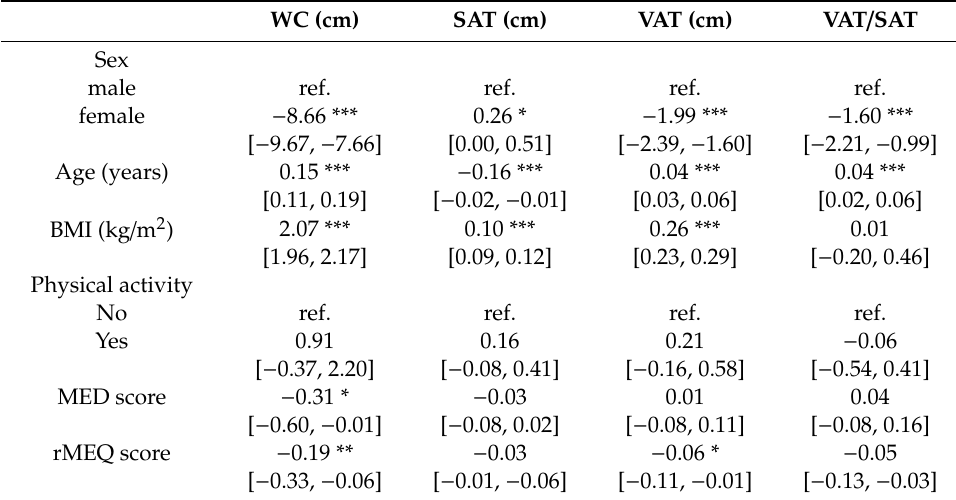
Table 3. Association between chronotype and abdominal